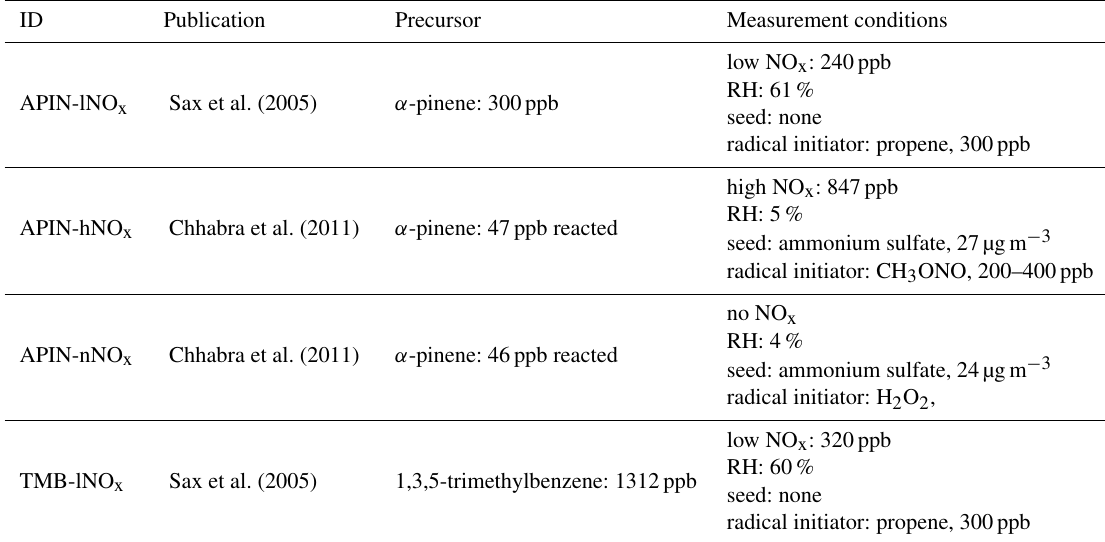
Table 1. Summary of the experimental conditions studied in this work. For simplification, an ID has been given to each